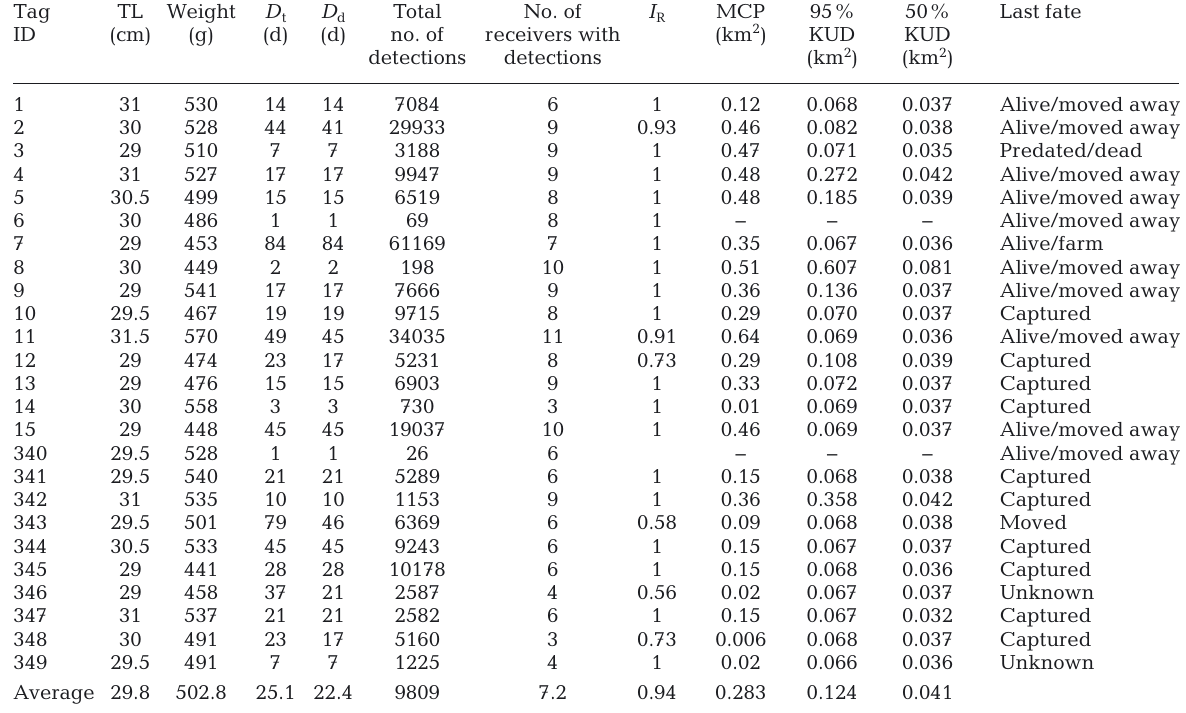
Table 1. All Sparus aurata (N = 25) tagged with an acoustic transmitter, with (IDs 1−15) or without (IDs 340−349) a depth sensor. TL: total length;